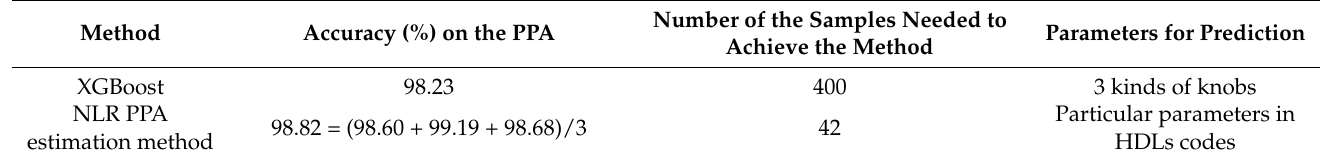
Table 1. The proposed method and the state of art methods for PPA prediction in HLS. Method